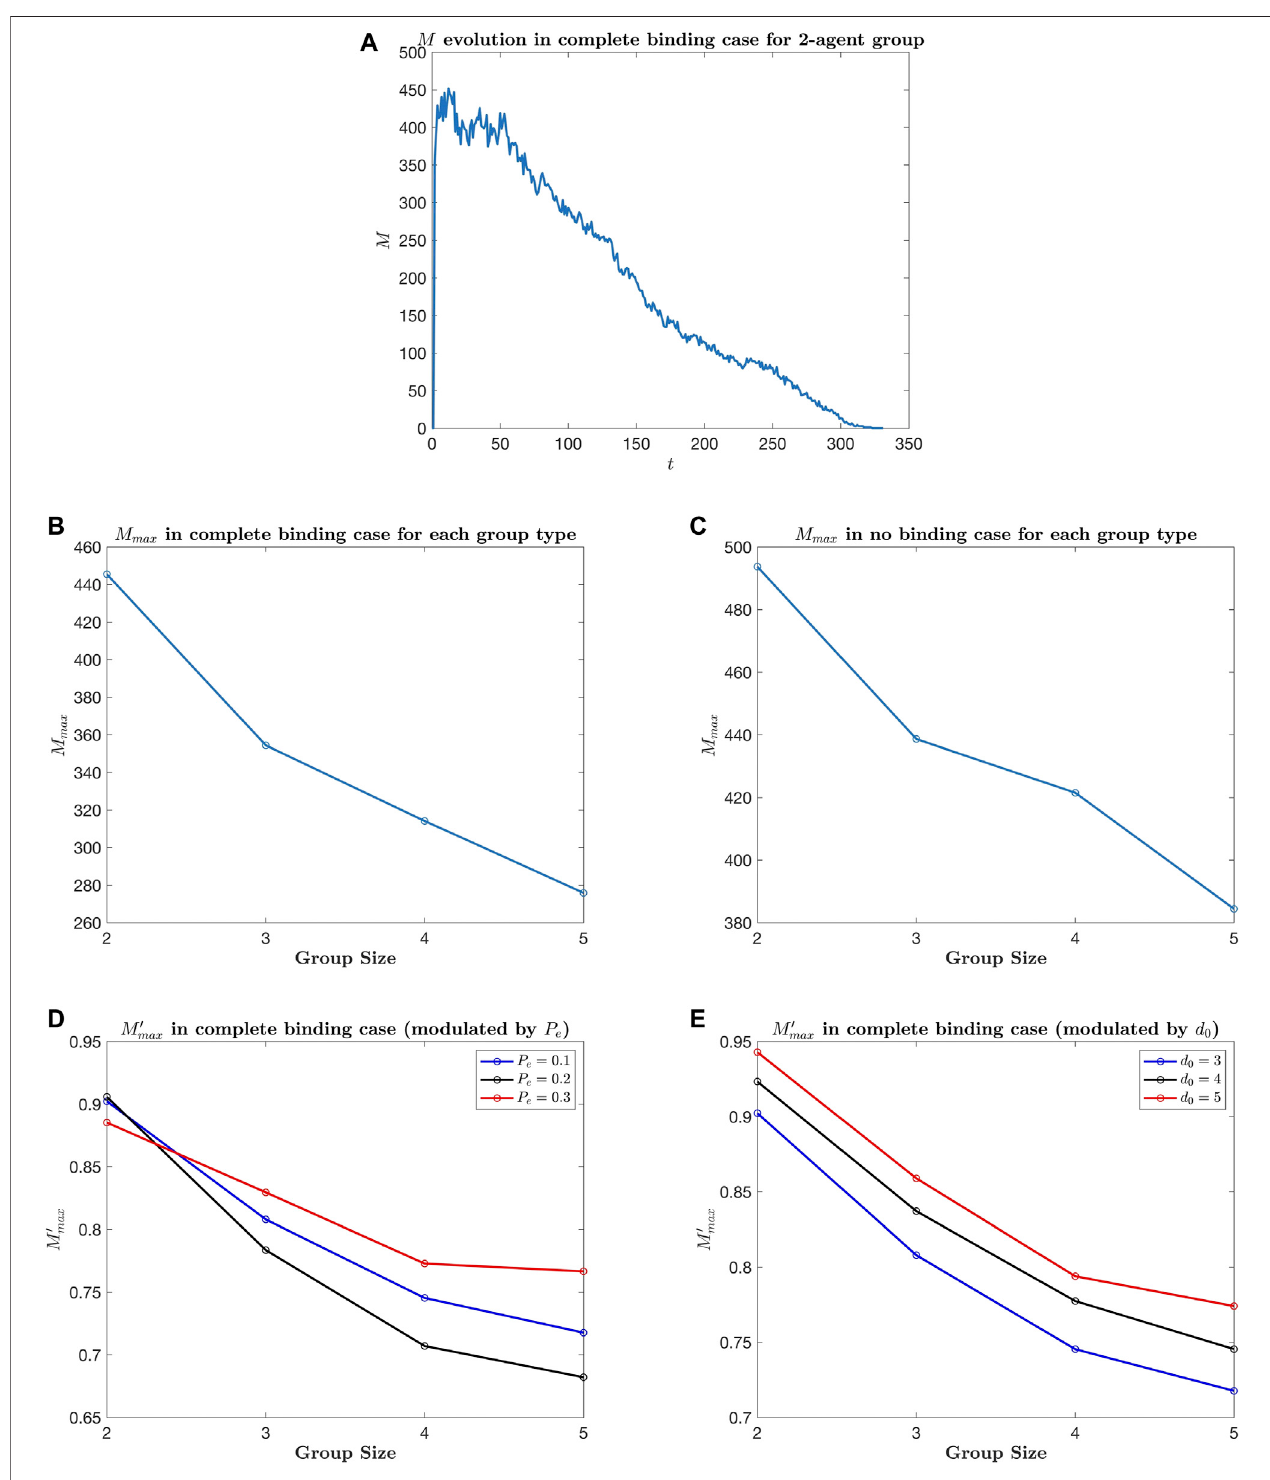
FIGURE 10 | Time evolution of M for the simulation of 2-agent group evacuation in the complete binding case is shown in (A) . The maximum of the system mixing index M max versusgroupsizeinbothcompletebindingandnobindingcasesareshownin (B,C) .Therelationbetweenthenormalized mixingindex M max ′ andgroupsize in the complete binding case with the binding strength modulated by both P e and d 0 are in (D,E) .